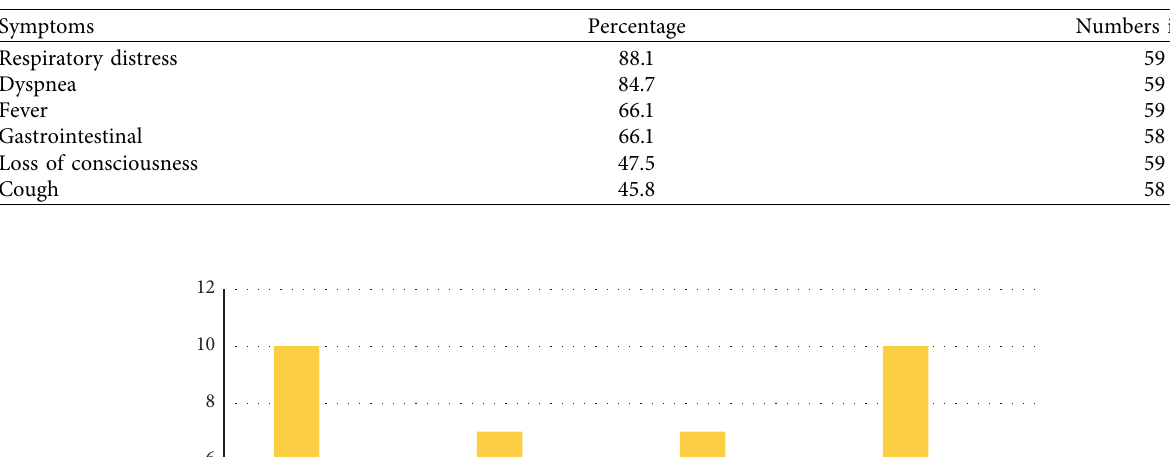
Table 2: Common symptoms in total patients.